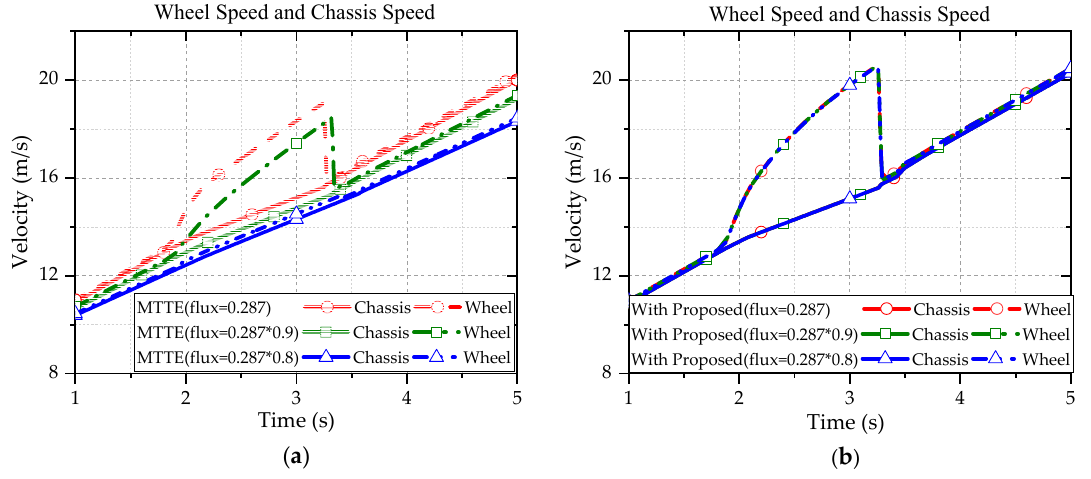
Figure 11. Comparison of wheel speed and chassis speed under the change of flux linkage: ( a ) vehicle with MTTE; ( b ) vehicle with proposed control strategy.